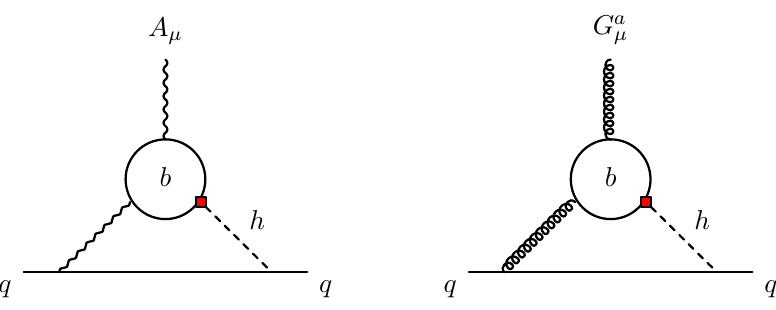
Figure 1 . Photonic and gluonic “Barr-Zee” diagrams with modified bottom-Yukawa coupling that induce an EDM of the light quark q . See text for